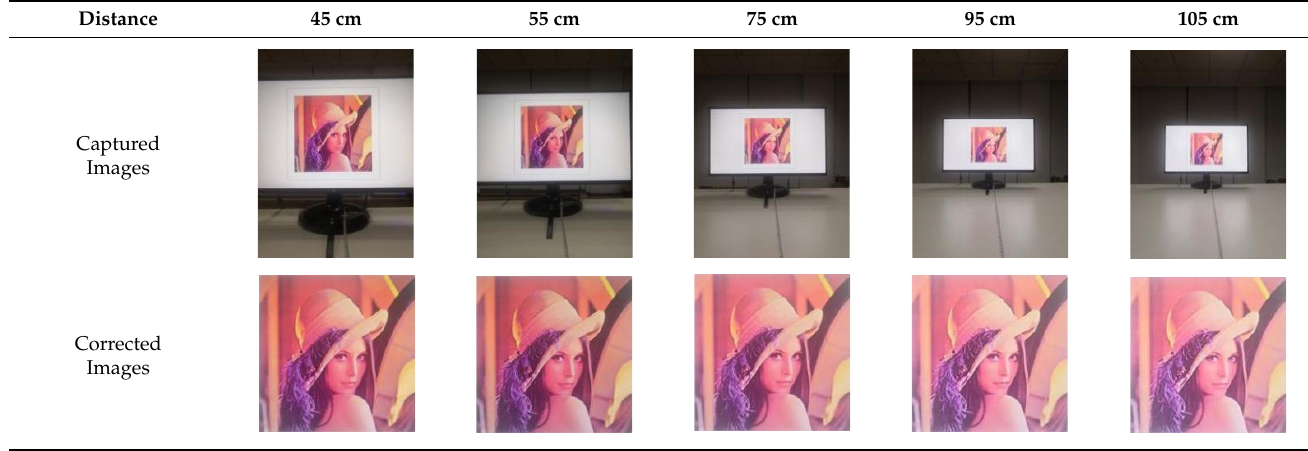
Table 4. Captured and corrected images at different capturing distances.